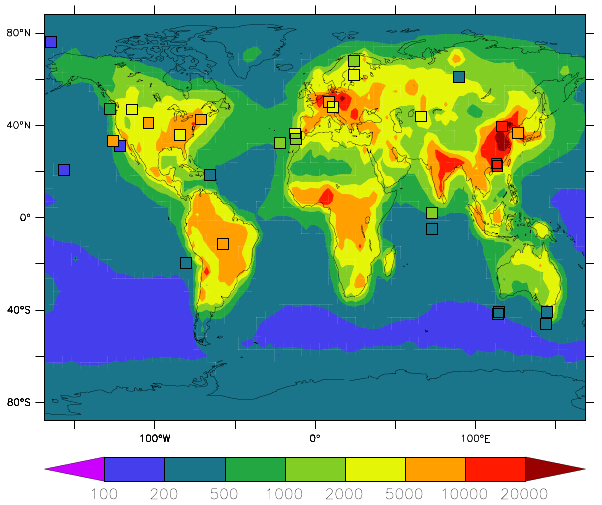
Fig. 4. Annual mean surface aerosol number concentration (cm − 3 ) compared to observed values (from a range of time periods) col- lected by Andreae (2009). Simulated values show total particle number in the Aitken, accumulation and coarse modes. Observa- tions have a range of cutoff